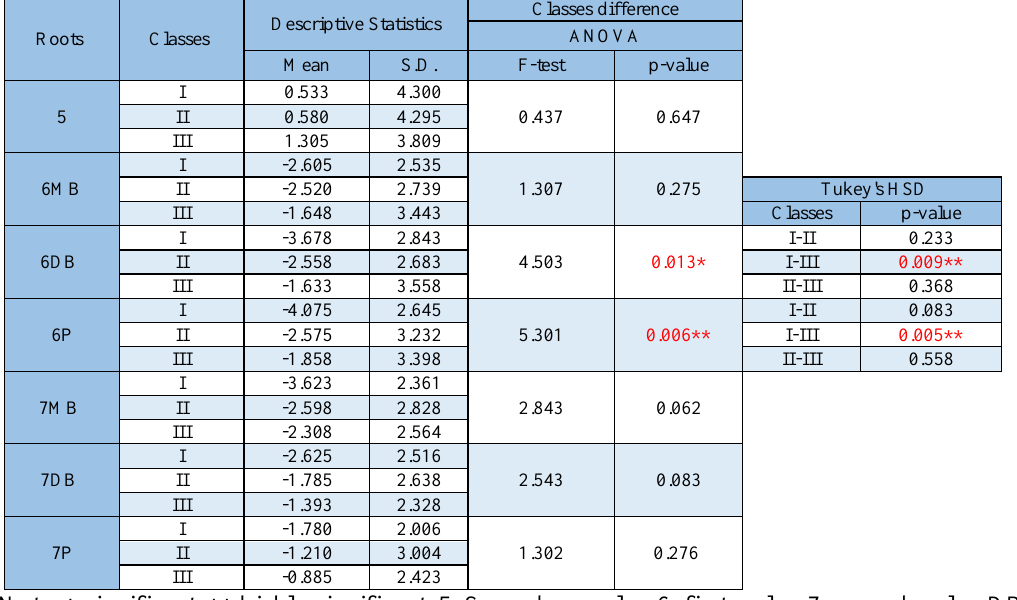
Table 1: Distances between the sinus floor and root tips on CBCT according to classes Roots